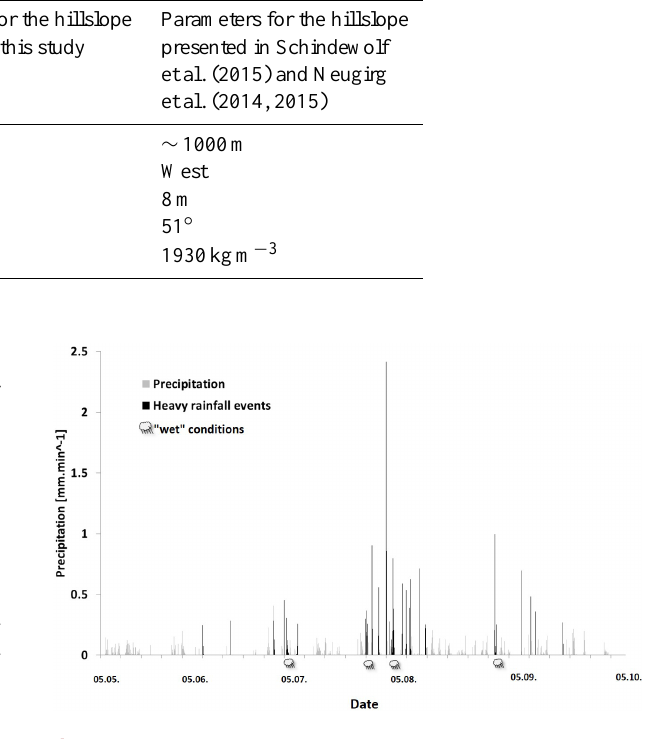
Figure 2. Precipitation for the monitored and modeled period with the filtered events and wet soil conditions for model parametriza-